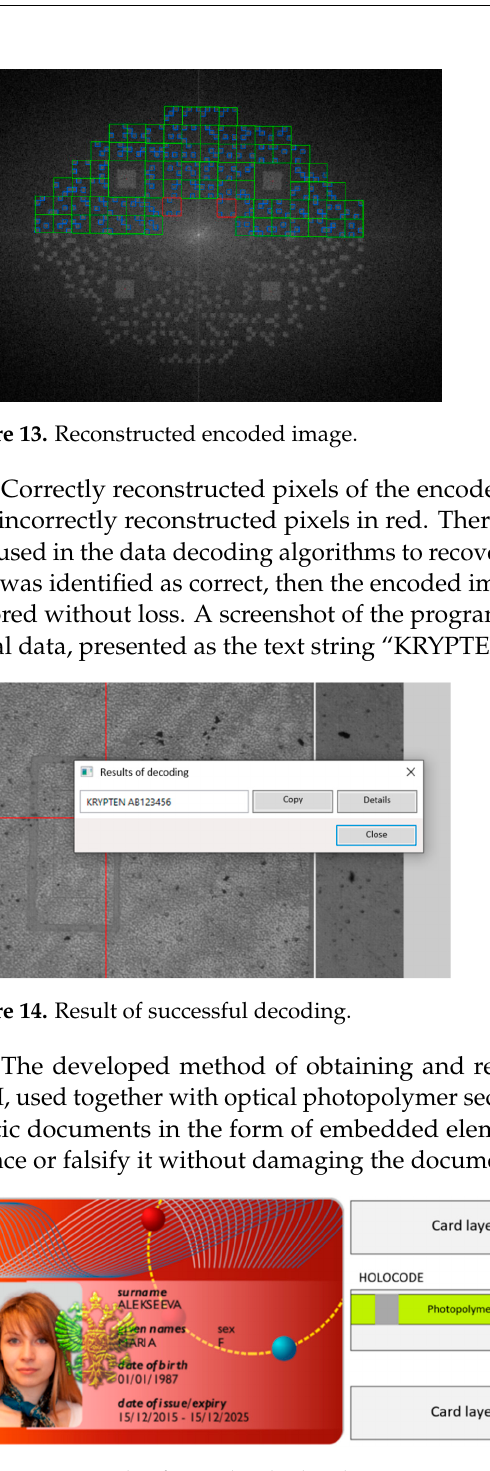
Figure 16. Model of interaction between B2G and G2C with the use of Holomemory. 6. Conclusions In the present article, the described applications of holographic memory computer- generated holograms indicated a wide coverage of their use in security printing and informative marks production and management. The basic features of the CGH-based approach are simplicity of its realization that does not require complex interferometric setups, high repeatable accuracy, and the possibility of the usage of simple equipment suited with a digital camera, such as a smartphone, for originality verification. It can be confidently stated that the development of applications of computer-generated holograms remains relevant and promising. So, it is very likely that we will see many more interesting applications of computer-generated holograms in the future. Author Contributions: Conceptualization, E.Y.Z. and V.V.K.; methodology, E.Y.Z., V.V.K. and D.S.L.; software, E.Y.Z.; validation, E.Y.Z., V.V.K., D.S.L. and A.V.S.; formal analysis, V.V.K.; investigation, V.V.K. and D.S.L.; resources, D.S.L. and A.V.S.; data curation, V.V.K.; writing— original draft preparation, E.Y.Z., V.V.K., and A.V.S.; writing—review and editing, E.Y.Z., V.V.K.; visualization, D.S.L.; supervision, V.V.K.; project administration, V.V.K. and E.Y.Z.; funding acquisition, A.V.S. All authors have read and agreed to the published version of the manuscript.